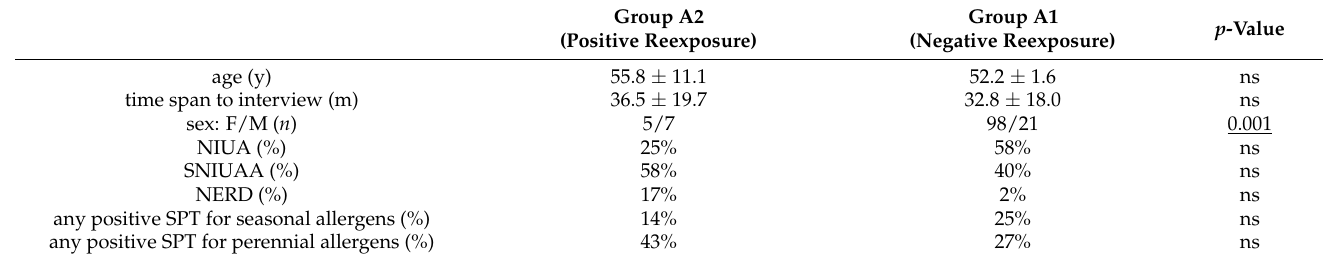
Table 2. Comparison of group A1 with group A2 in terms of clinical and demographic characteristics.